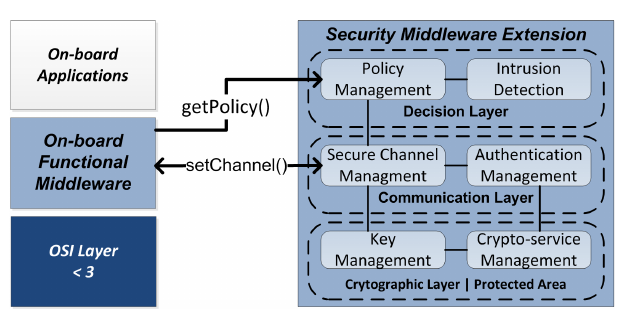
Figure 2. Architecture of the security middeware extension and its association to a functional